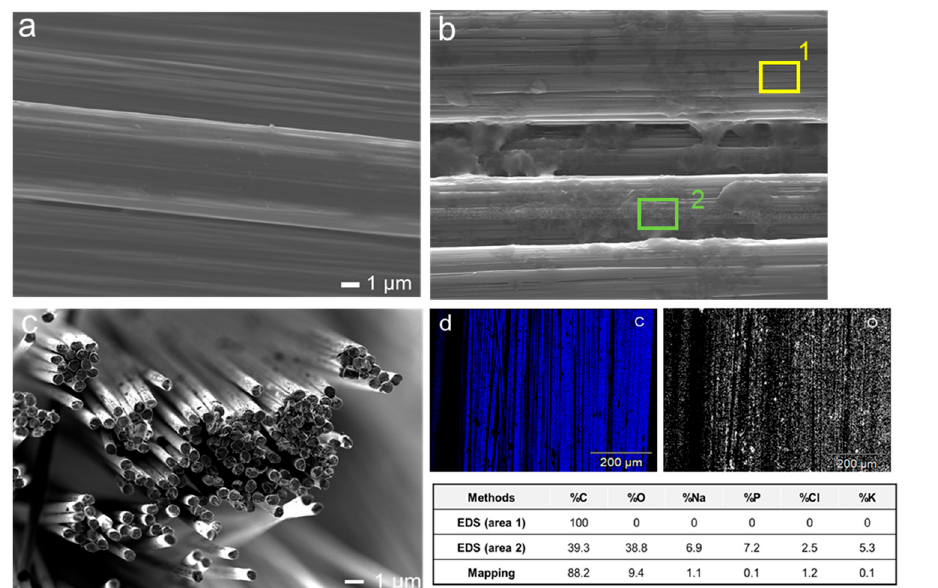
Figure 3. Scanning electron microscope image ( a ) uncoated carbon fibre; ( b ) carbon fibre coated with rGO using 3 CV cycles (table gives values for areas not coated (area 1) and coated with rGO (area 2); ( c ) bundle of bare carbon fibre; ( d ) Energy-dispersive X-ray spectroscopy (EDS)—mapping im- ages of the 3 CV cycles rGO showing chemical composition of Carbon and Oxygen.